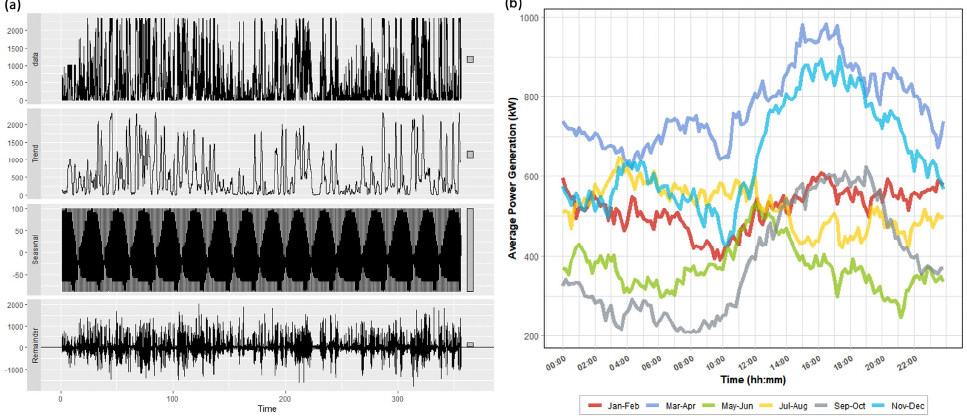
Figure 3. Time—series plot of wind power generation: ( a ) Time series plot of seasonal and trend decomposition using loess (STL decomposition), ( b ) Average 10 min power generation per season.